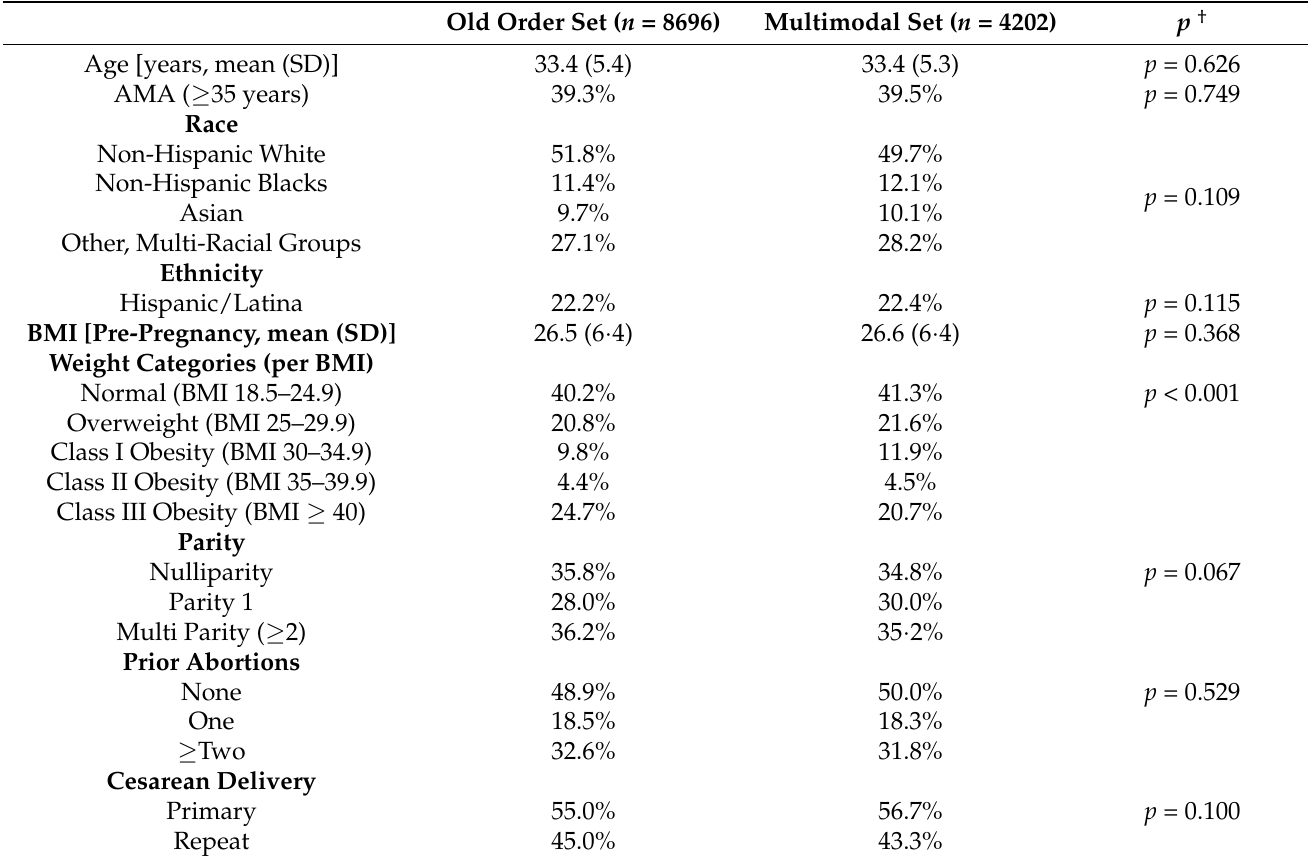
Table 2. Demographic and Baseline